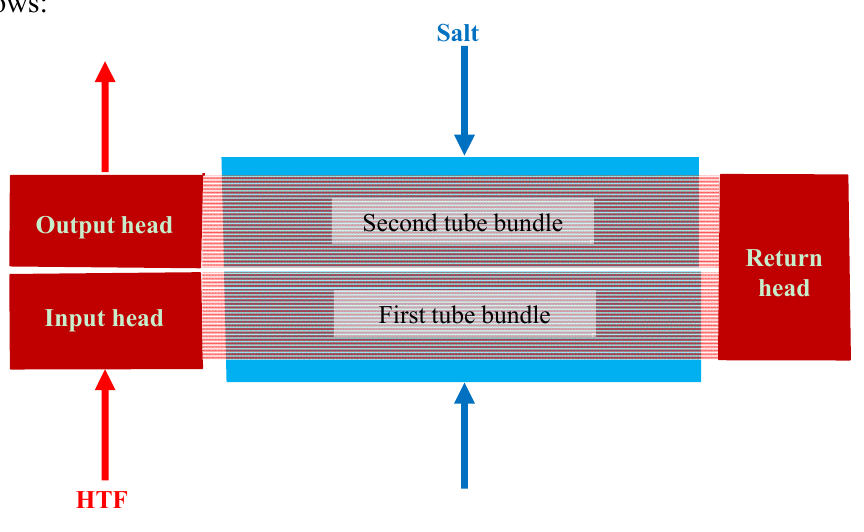
Figure 8. Components of an HTF-Salt heat